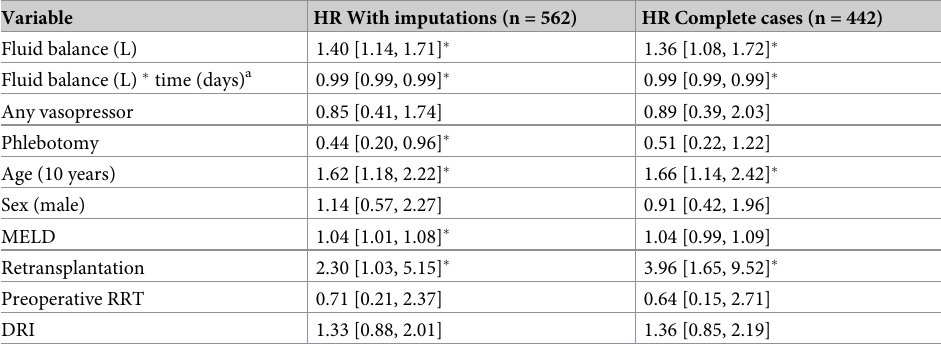
Table 5. Survival up to 1